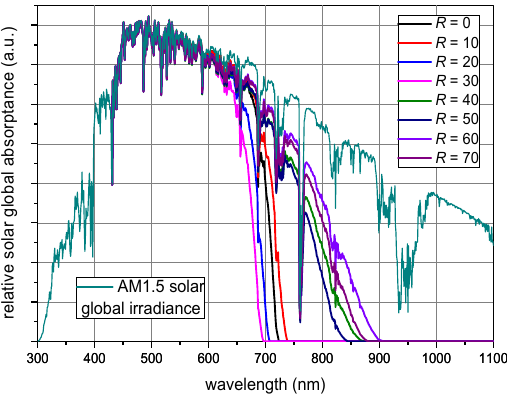
Figure 7. Relative absorptance of solar global spectral irradiance AM1.5 (dark cyan).